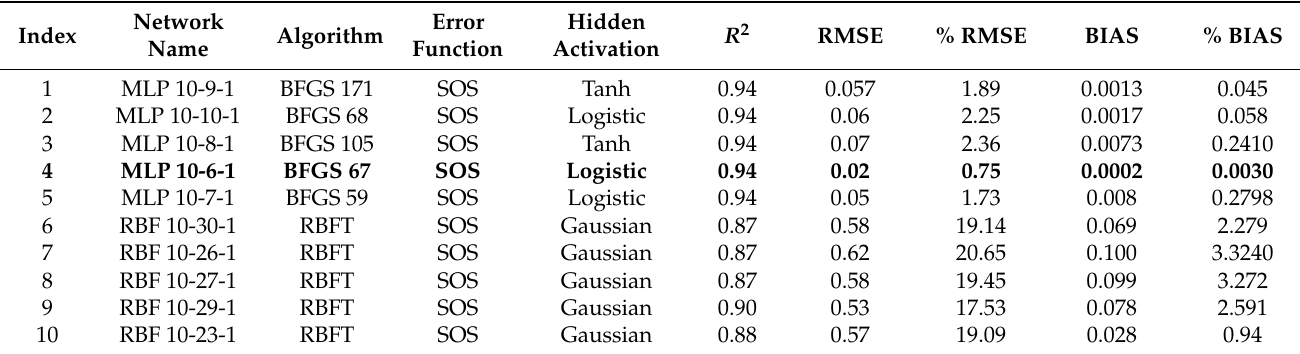
Table 4. Characteristics of RBF and MLP-based ANNs and associated metrics for SR model